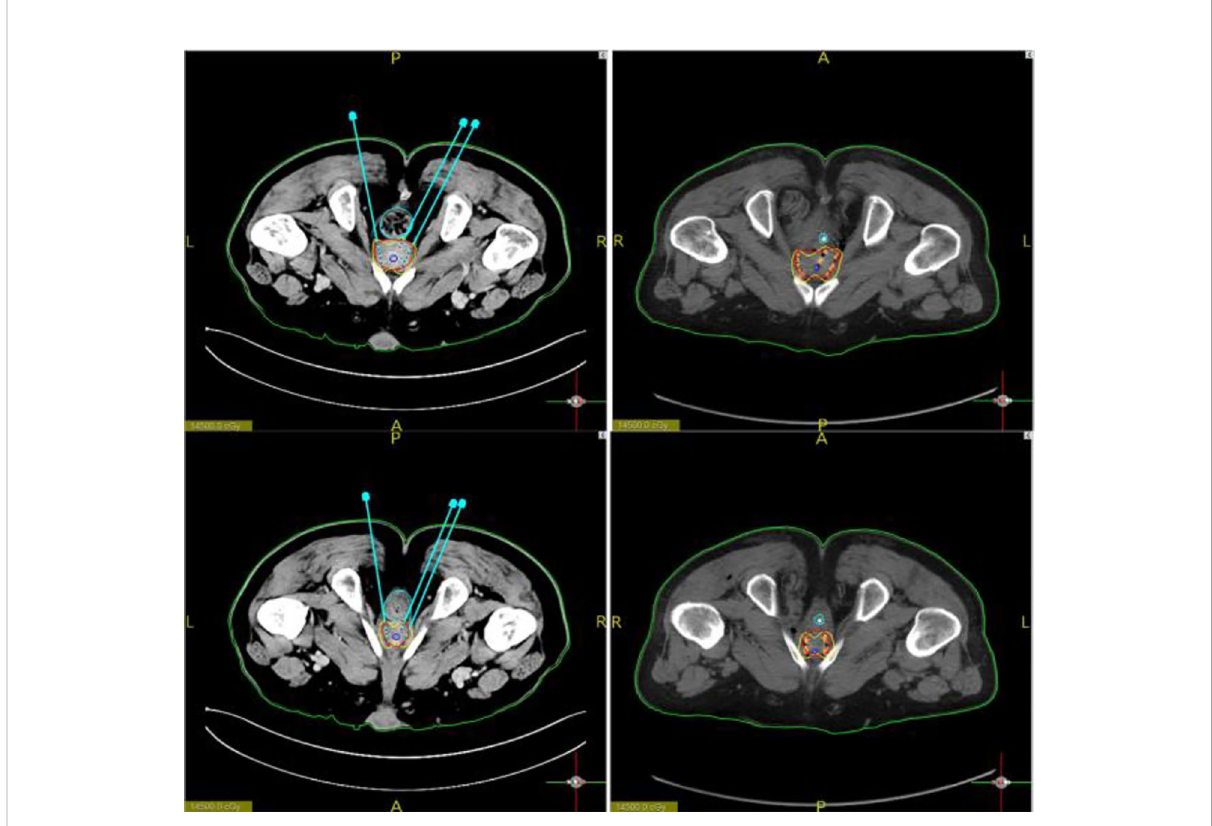
FIGURE 5 Images showing particle positions. Particle positions according to the preoperative plan and the postoperative image basically coincided.